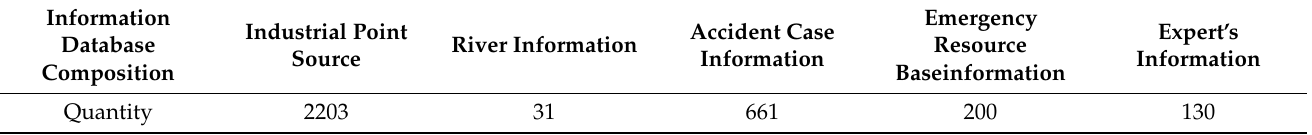
Table 7. Transboundary region risk source basic information